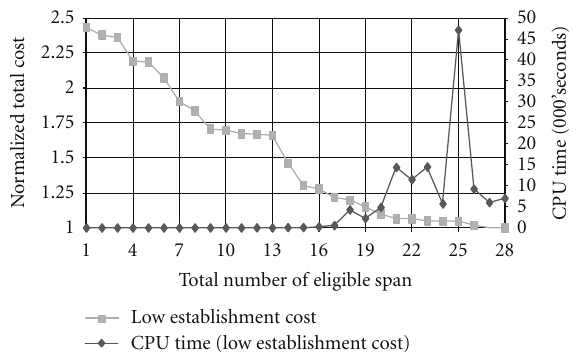
Figure 8: Total network costs and CPU time versus the number of eligible spans for the 40-node